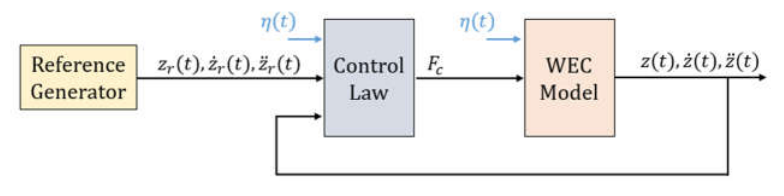
Figure 3. Configuration of proposed control schemes.